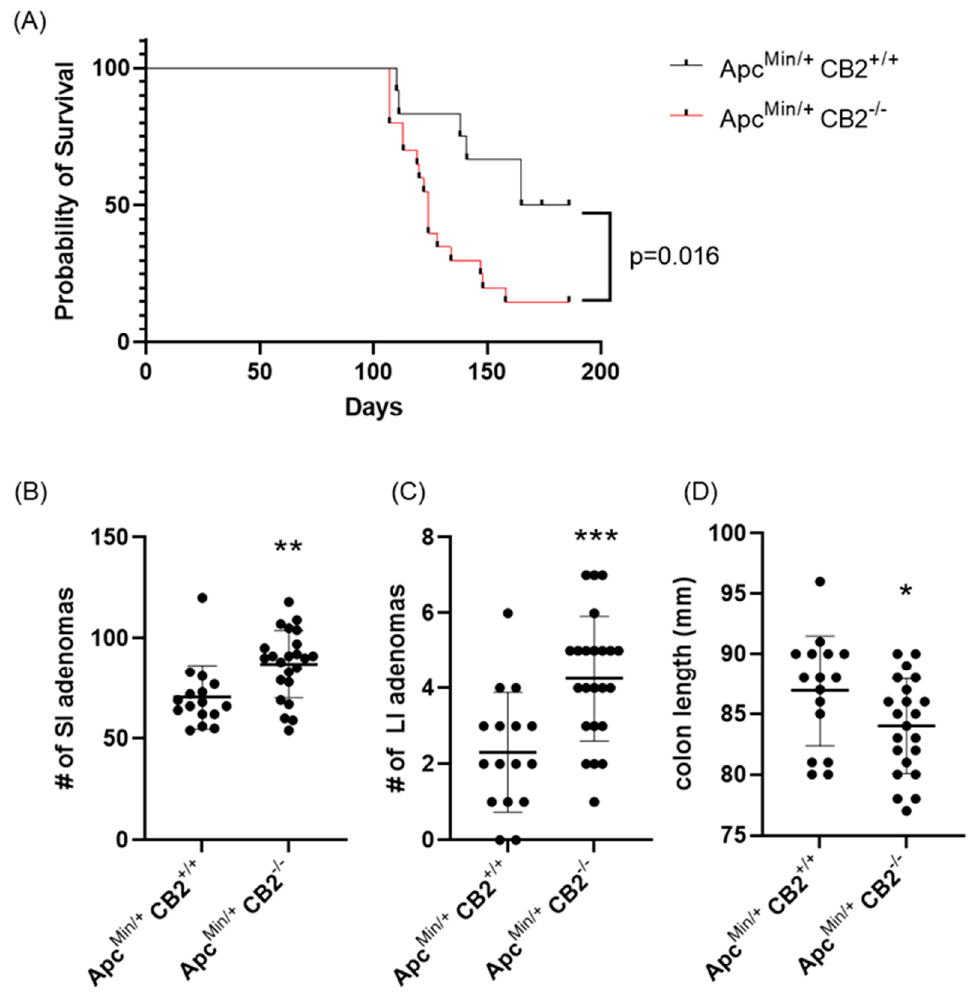
Figure 4. The CB2 receptor protects against cancer progression in the Apc Min/+ male and female mice. ( A ) Survival curve, ( B ) number of adenomas in the small (SI) and ( C ) large intestine (LI), and ( D ) colon length. Apc Min/+ CB2 +/+ , n = 12 (6 females and 6 males); Apc Min/+ CB2 − / − , n = 20 (8 females and 12 males), Kaplan–Meier (survival curve), Apc Min/+ CB2 +/+ , n = 16 (8 females and 8 males); Apc Min/+ CB2 − / − , n = 23 (10 females and 13 males), Mann–Whitney U test or Student’s t -test, * p < 0.05, ** p < 0.01, *** p < 0.001.